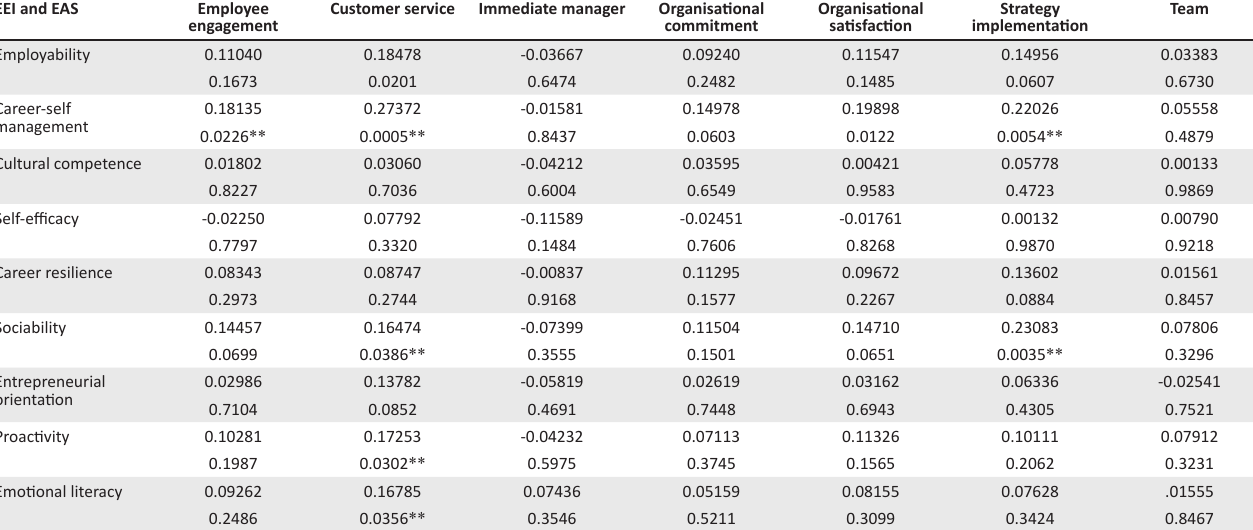
TABLE 3: Correlations between subscales of employee engagement and self-perceived employability: Pearson product-moment correlation coefficients, N = 158. EEI and